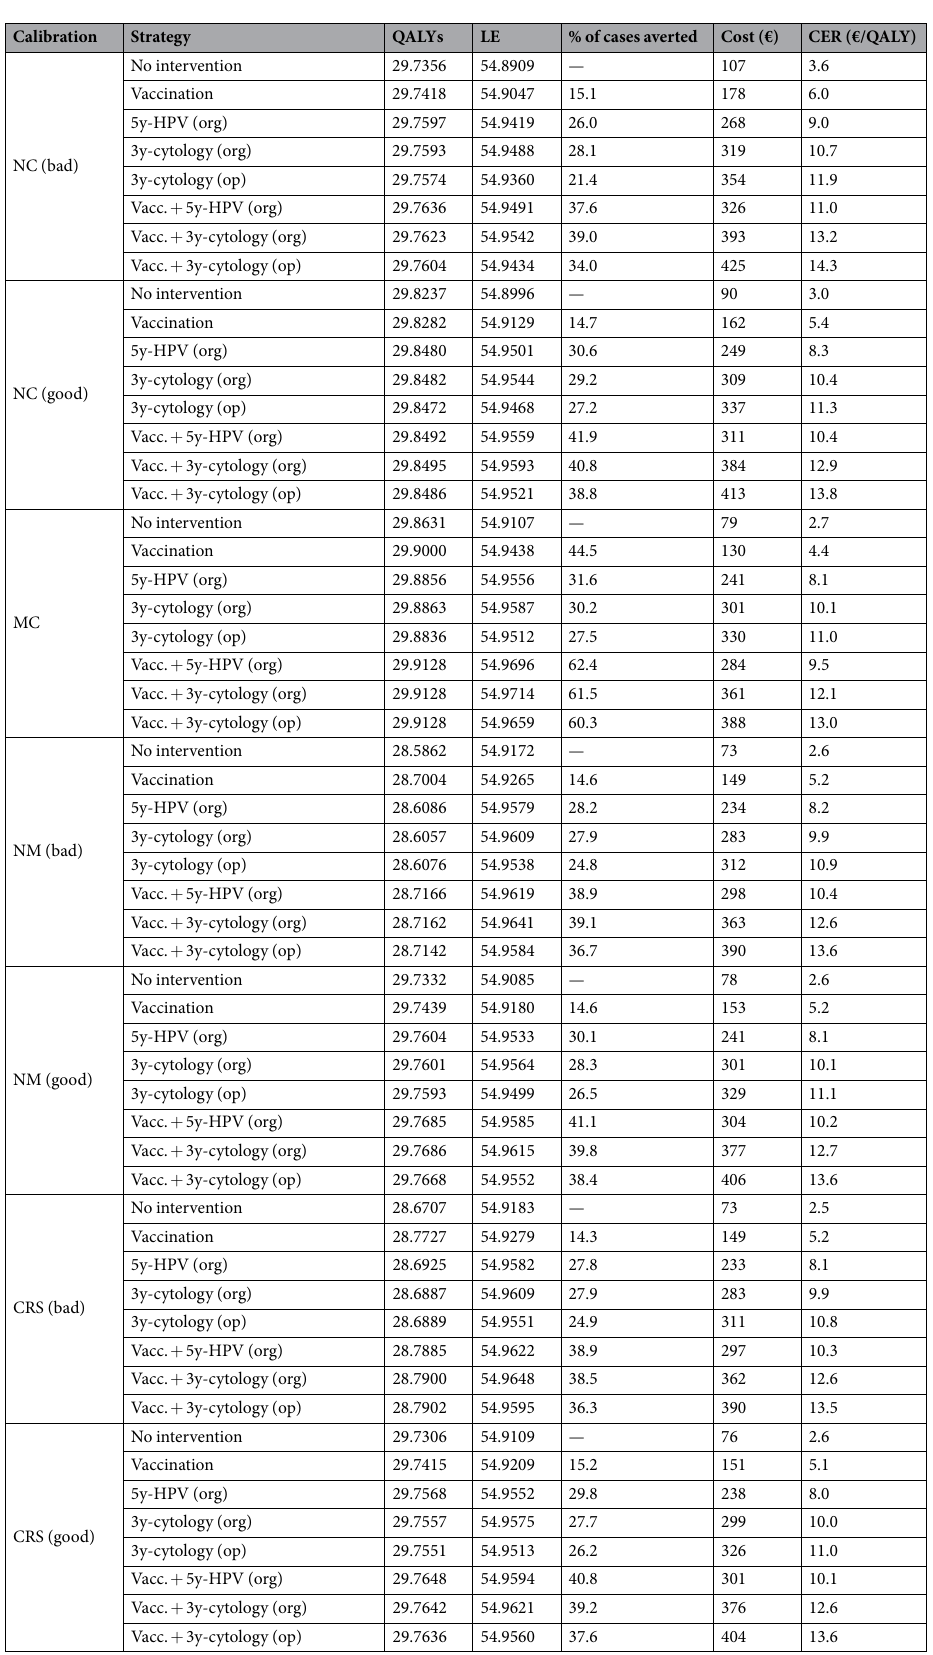
Table 2. Cost-effectiveness outcomes by calibration approach and input matrix. LE = Life expectancy, NC = No calibration, MC = Manual calibration, NM = Nelder-Mead, CRS = Controlled random